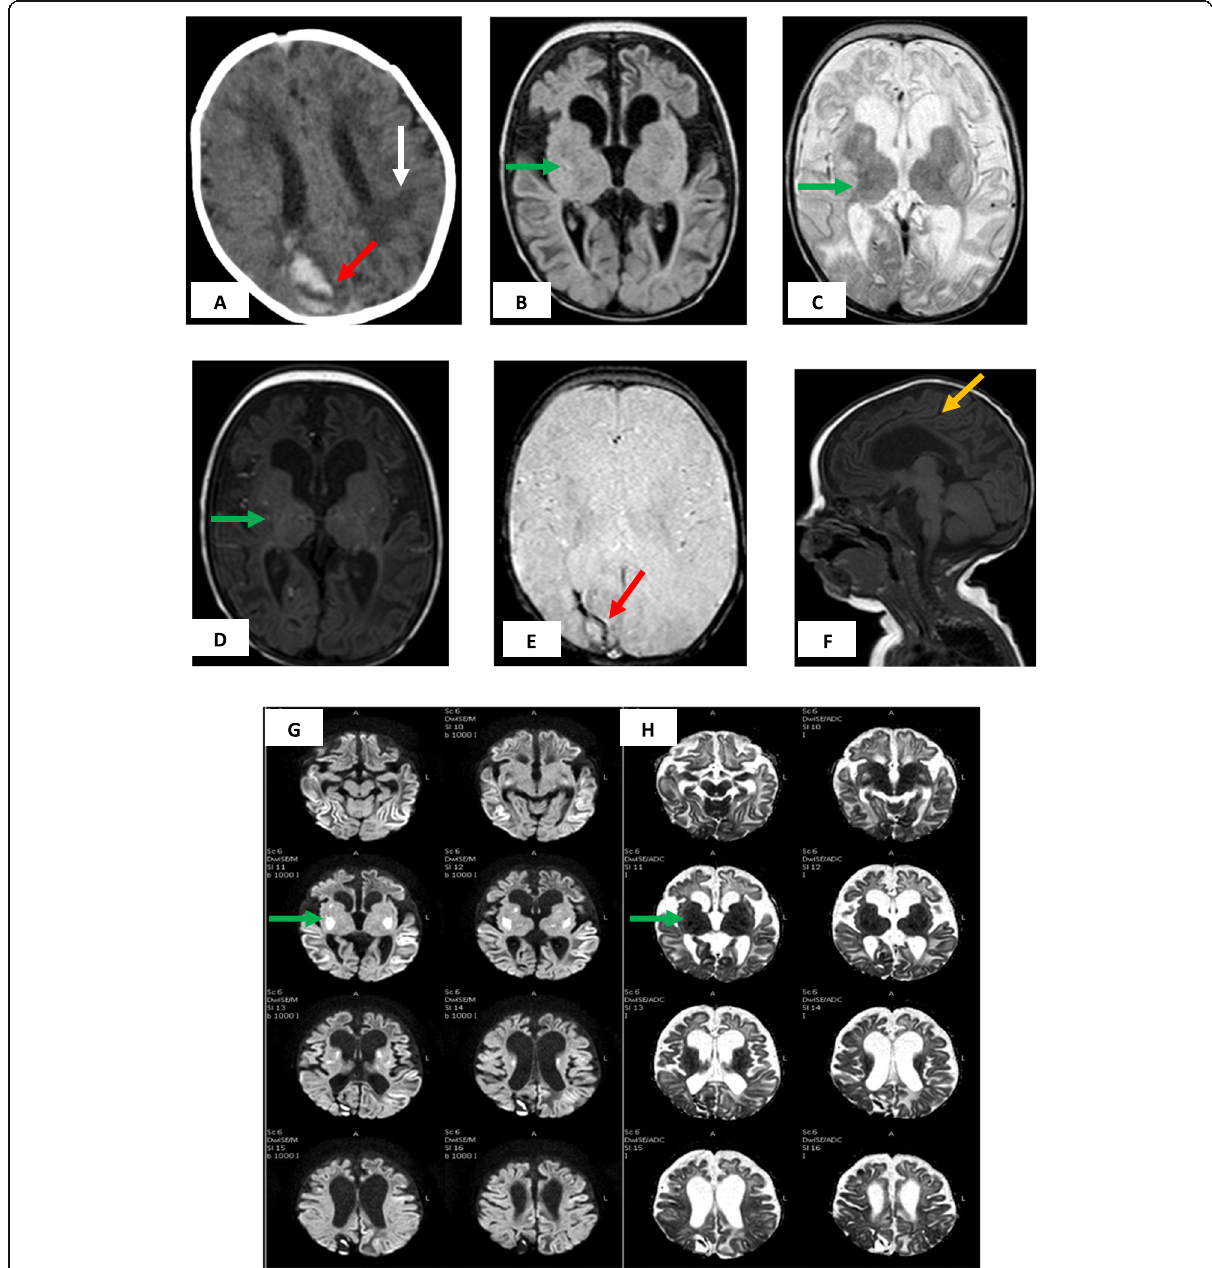
Fig. 8 4 month-old male with MELAS [ A ] Non-contrast CT showing periventriculer hypodensities (white arrow) and right occipital hematoma (red arrow). Different sequences axial MRI, [ B ] FLAIR, [ C ] T2WI, [ D ] T1WI, showing isointense signal of the basal ganglia (green arrow), thalami and tempro-parietal cortical gyri at T1 and FLAIR, low signal at T2 with dilated ventricular system. [ E ] Axial T2* showed minimal blooming (red arrow), [ F ] sagittal T1 showing markedly thinned corpus callosum (yellow arrow) [G] DWI b1000, [ H ] ADC map showed restricted diffusion at the previous sites (green